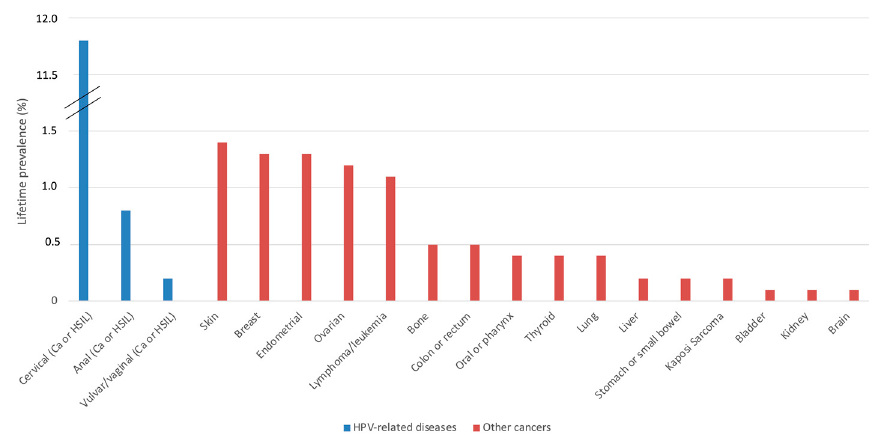
Figure 1. Prevalence of self-reported lifetime diagnoses of cancers or pre-cancers in participants from the Canadian HIV Women’s Sexual and Reproductive Health Cohort Study (CHIWOS, n =